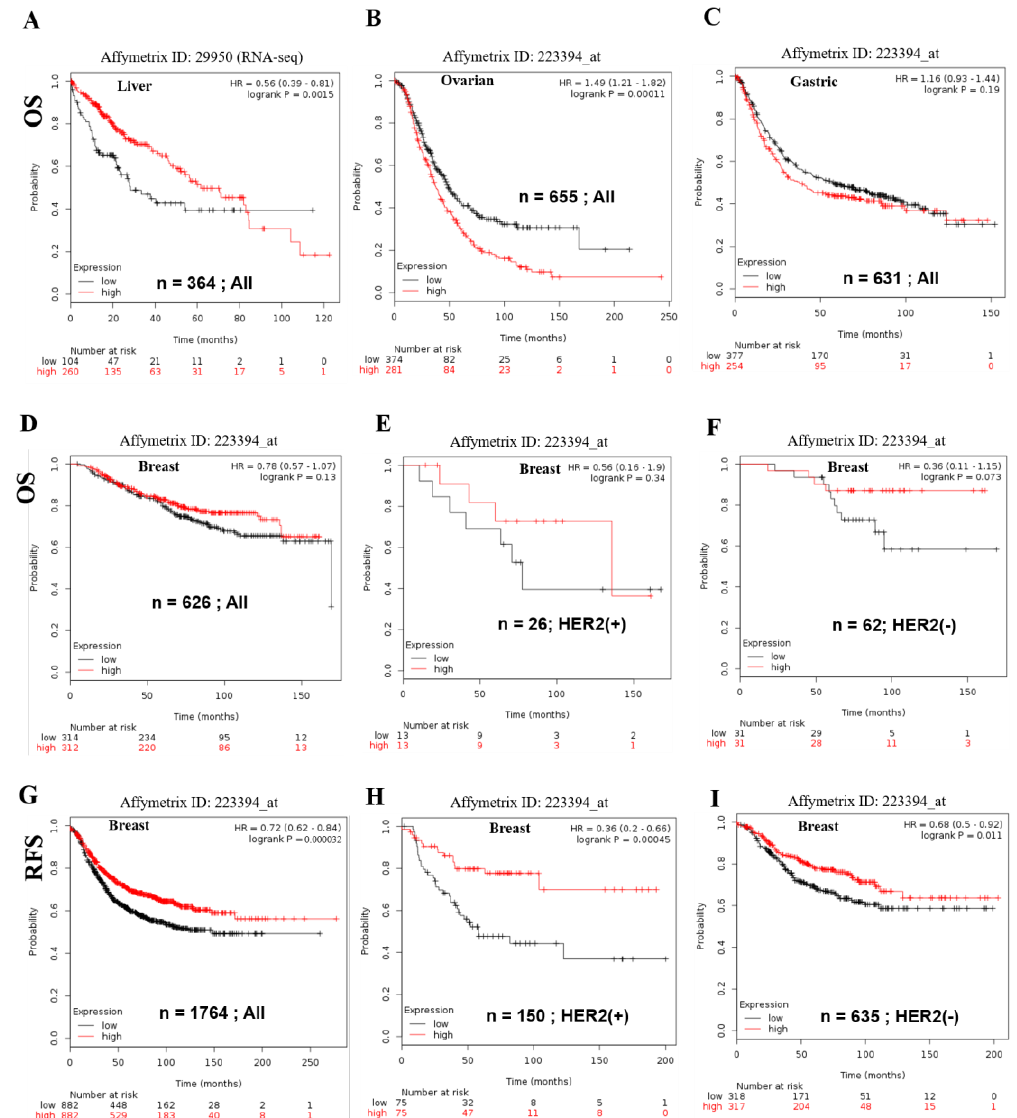
Figure 3. Kaplan-Meier overall survival curves for patients with different cancer cohort’s analysis. ( A ) Kaplan-Meier Survival plotter (KM-plotter) relationship between SERTAD1 expression and its effect on survival ( p = 0.0015) on liver, ( B ) on ovarian ( p = 0.00011), ( C ) on Gastric ( p = 0.19), ( D ) breast ( p = 0.13) cancer all, ( E ) HER2 (+) breast ( p = 0.34) cancer, ( F ) HER2 ( − ) breast ( p = 0.073) cancer, ( G ) Relapse free survival for breast ( p = 0.000032) cancer all, ( H ) Relapse free survival for HER2 (+) breast ( p = 0.00045) cancer, ( I ) Relapse free survival for HER2 ( − ) breast ( p = 0.011) cancer. The p -values were calculated using the log-rank test. Vertical hash marks indicate censored data. The survival curve comparing the patient with high (red) and low (black) expression of SERTAD1.